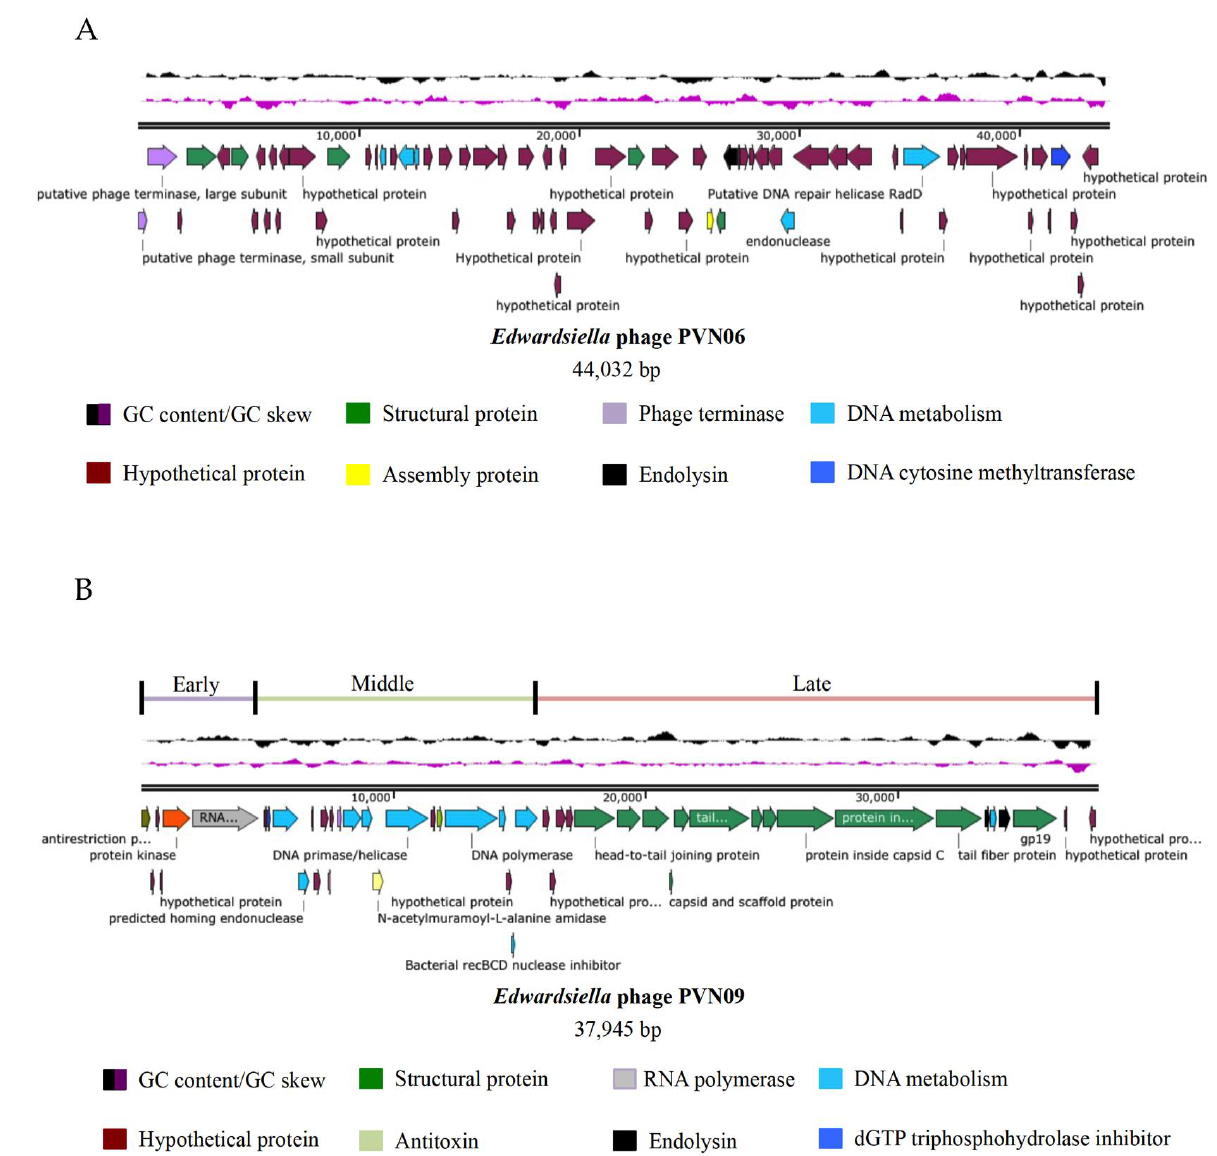
Figure 2. Linear genome map of the E. ictaluri phage PVN06 ( A ) and PVN09 ( B ). Annotations for predicted open reading frames (ORFs) are presented. The ORFs marks with different colors indicate categorized predicted functions of proteins. Two first plots represent a GC content (in black) and a GC skew (in violet) of the phage genome. E. ictaluri phage PVN09 is a T7-like phage and its genome can be divided into three parts of gene expression: early, middle, and late.